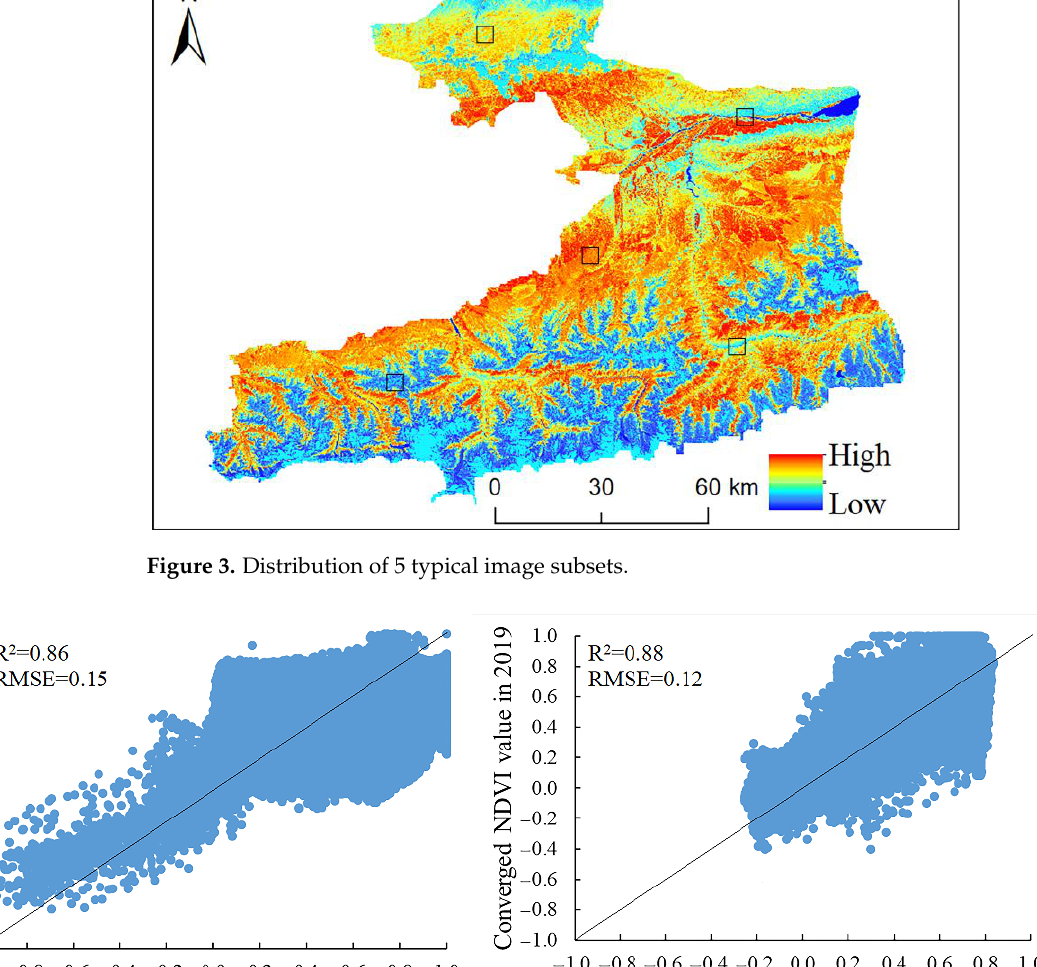
Figure 4. Scatter plot of fused NDVI and real NDVI and correlation coefficient.